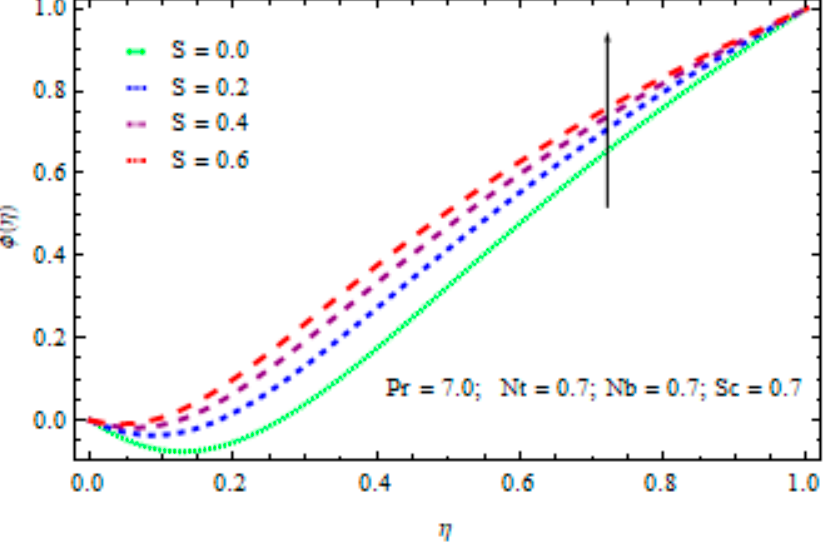
Figure 13. The impact of the unsteady parameter S on the temperature field.